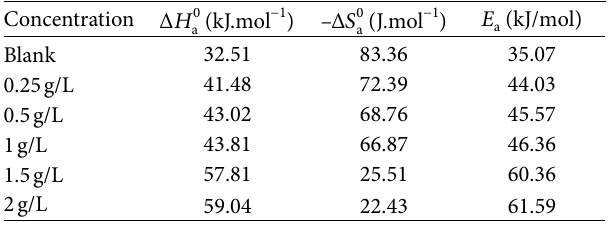
Table 6: Thermodynamic parameters.